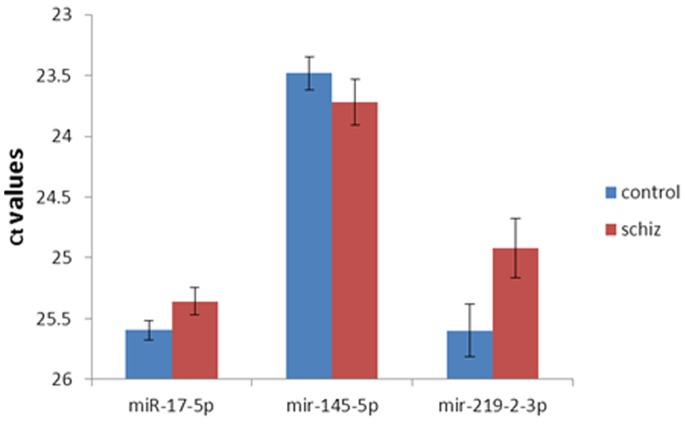
Manual RT-PCR measurements of 3 selected miRNAs agree very well with measurements performed by TLDA assay.The control and schizophrenia samples of Experiment 1 were measured using individual TaqMan primer sets for miR-17, miR-145-5p and miR-219-2-3p. Note that lower Ct values indicate higher abundance on a log2 scale (i.e., a decrease of 0.5 Ct represents a 41% increase in abundance or 1.41-fold difference across groups). Error bars indicate standard error of the mean. In this assay, miR-17-5p showed a 1.18-fold increase (p = 0.05), which is very close to 1.22-fold reported in Table 1. miR-145-5p showed a 0.85-fold change (p = 0.16), similar to 0.68-fold in Table 1. miR-219-2-3p showed a 1.60-fold increase (p = 0.029), similar to 1.48-fold in Table 1.